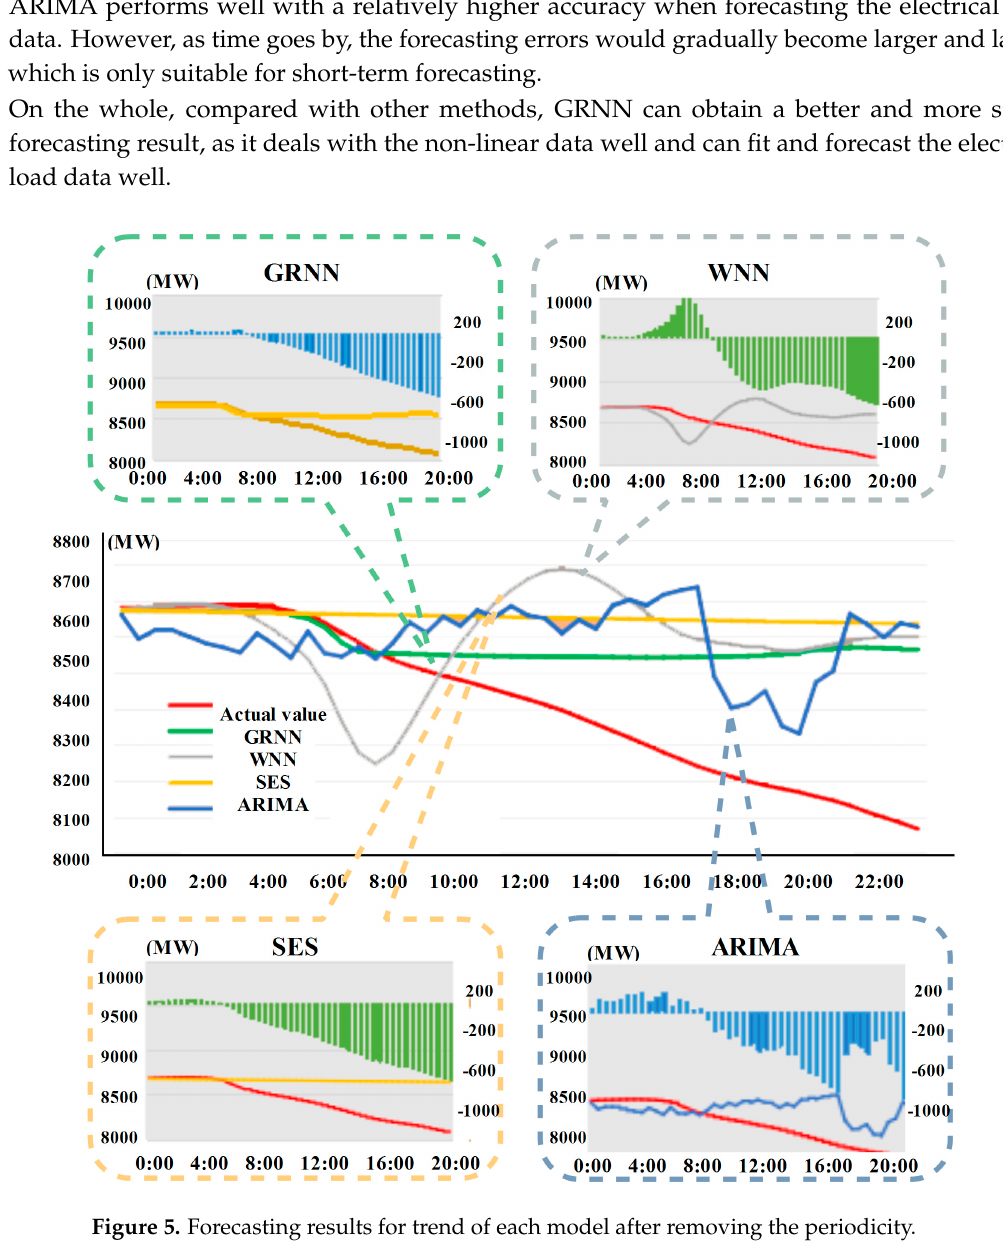
Figure 5. Forecasting results for trend of each model after removing the periodicity.